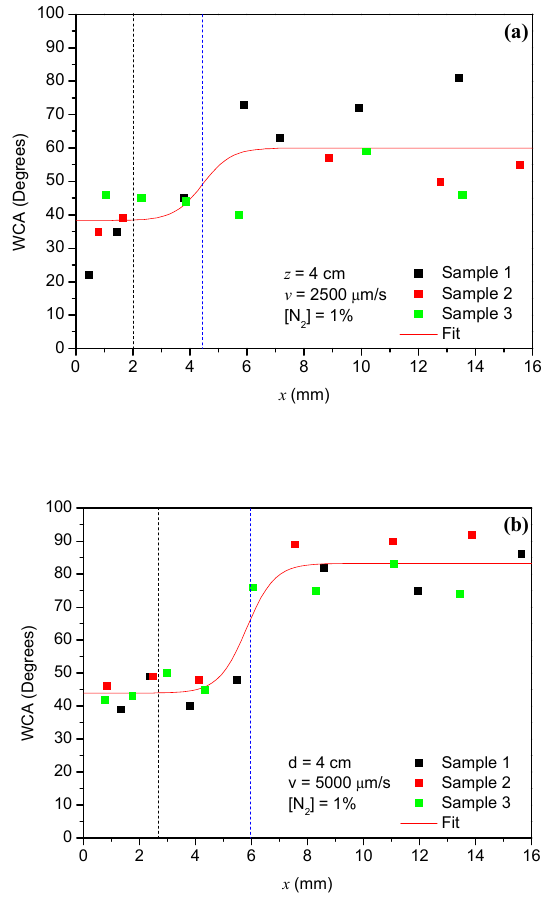
Figure 9. Water contact angle profile after Ar-N 2 postdischarge treatment at different speeds: ( a ) 2500 ( a ) 2500 µ m / s and ( b ) 5000 µ m / μ m/s and ( b ) 5000 μ m/s.